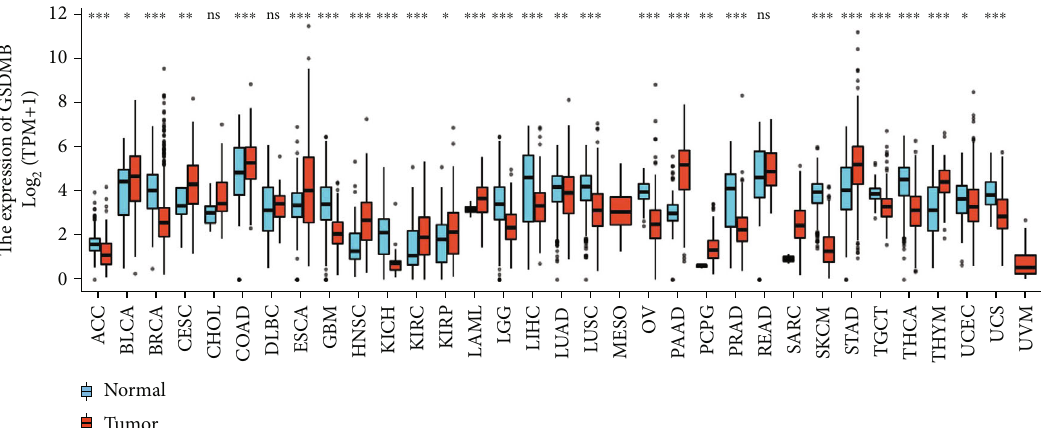
Figure 1: Expression pattern of GSDMB in a pan-cancer perspective. The mRNA expression of GSDMB was upregulated in 12 of 33 cancer types and downregulated in 15 of all 33 cancer types compared with normal tissues (ns: P ≥ 0 : 05 ; ∗ : P < 0 : 05 ; ∗∗ : P < 0 : 01 ; ∗∗∗ : P < 0 : 001